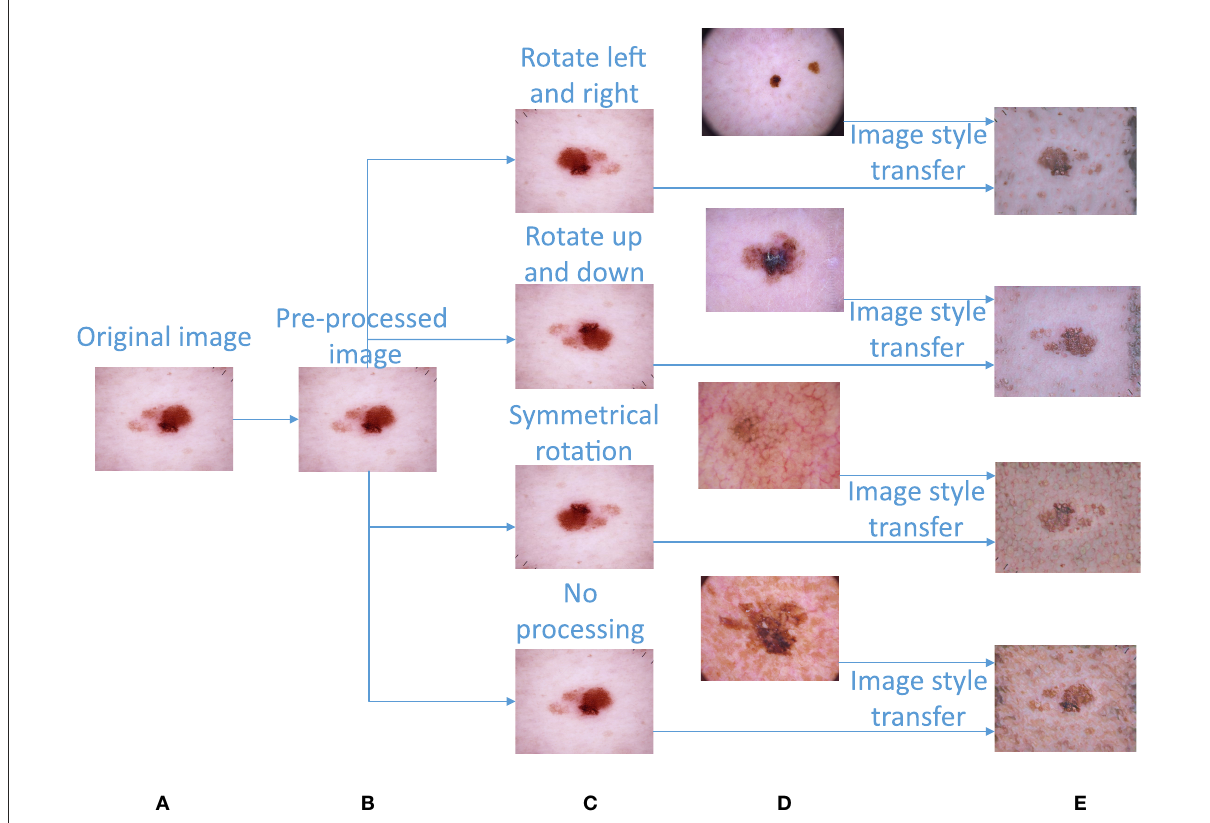
FIGURE3 Image preprocessing and image augmentation. (A) Original image. (B) Preprocessed image. (C) Image obtained after a basic rotation operation. (D) Image randomly extracted from image category c for image style transfer. (E) Composite image obtained after image style transfer.